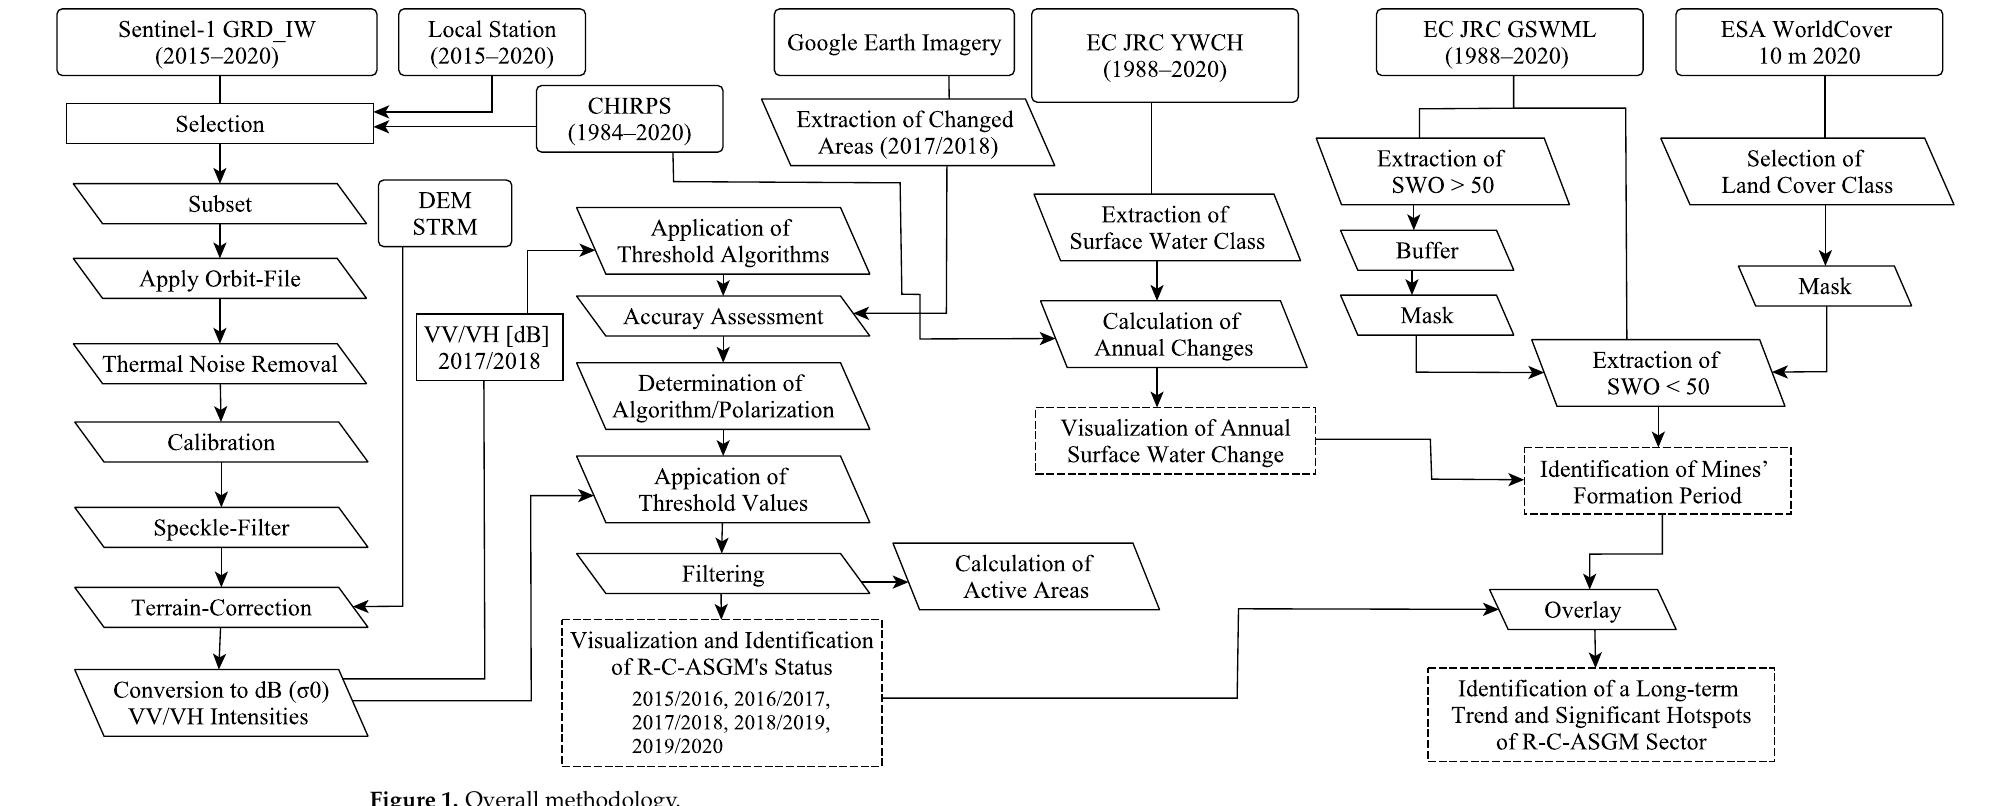
Figure 1. Overall